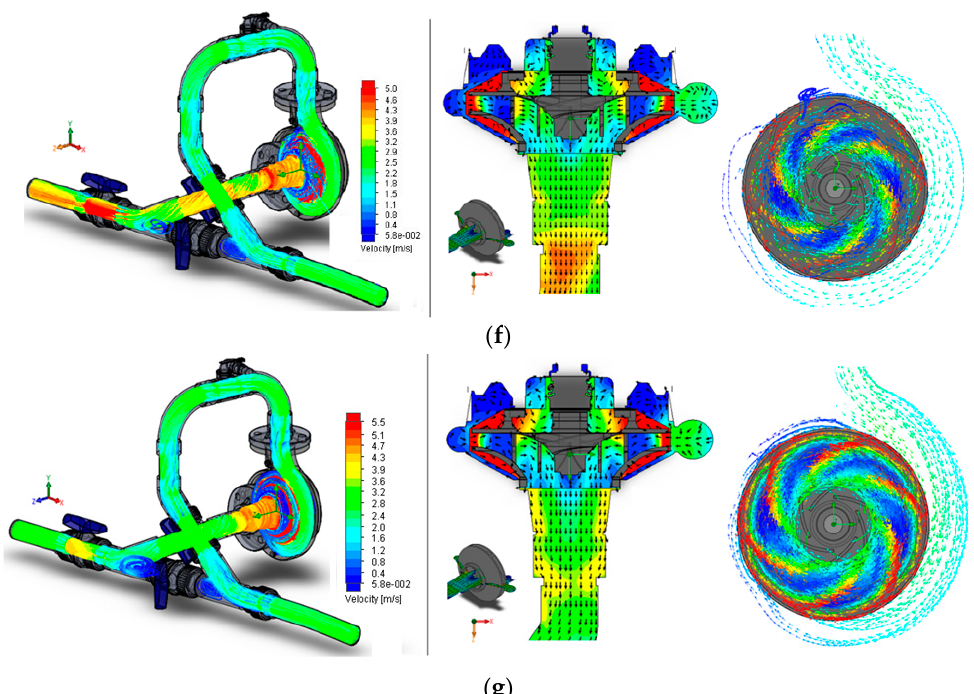
Figure 5. Velocity values for different rotational speeds (m/s): Streamlines (on the left); velocities field in the PAT (on the right). ( a ) N = 600 rpm; ( b ) N = 780 rpm; ( c ) N = 880 rpm; ( d ) N = 1020 rpm; ( e ) N = 1140 rpm; ( f ) N = 1250 rpm; ( g ) N = 1500 rpm.